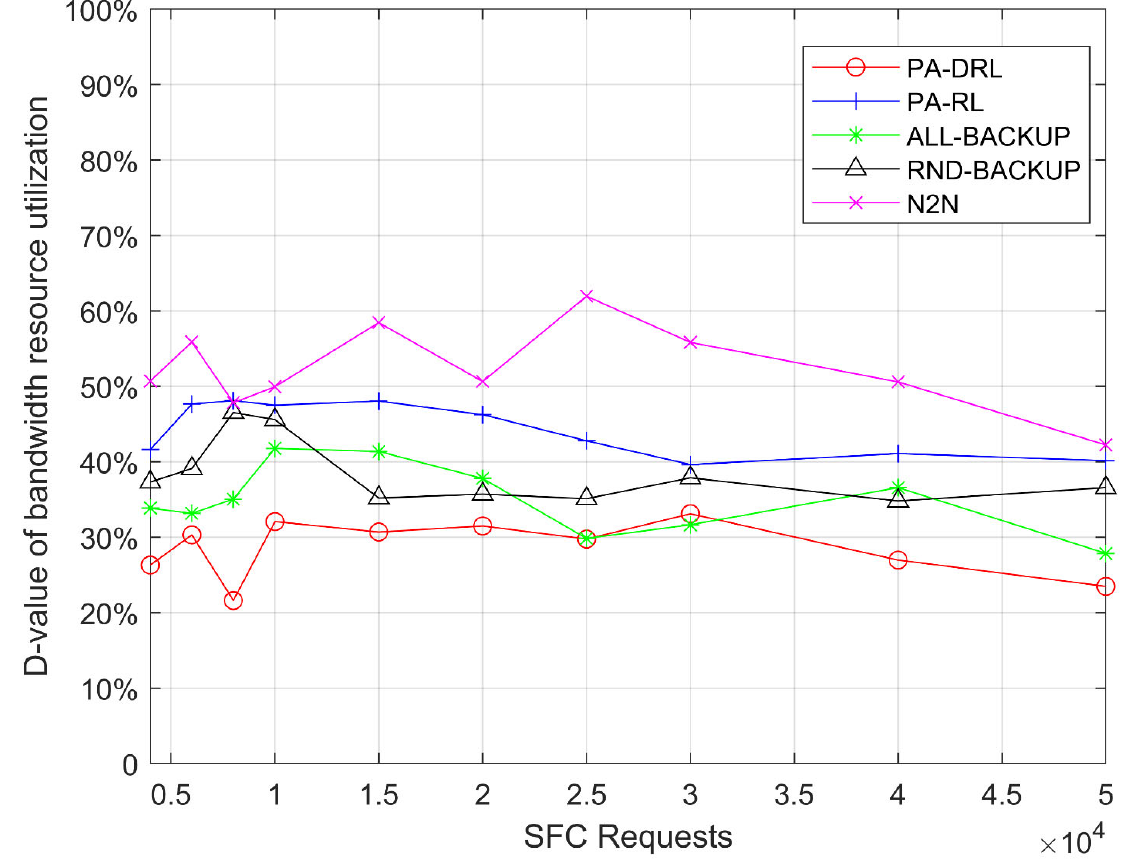
Figure 9. D ‐ value between maximum and average links’ resource utilization under each SFC requests number.